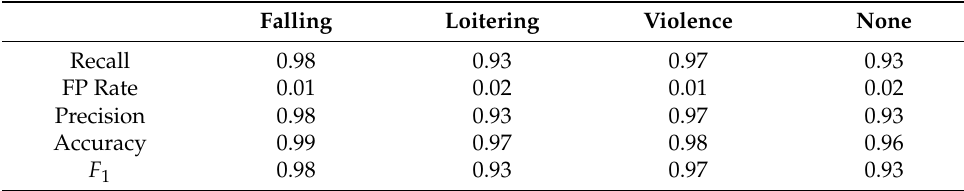
Table 7. Final classification test results for 4